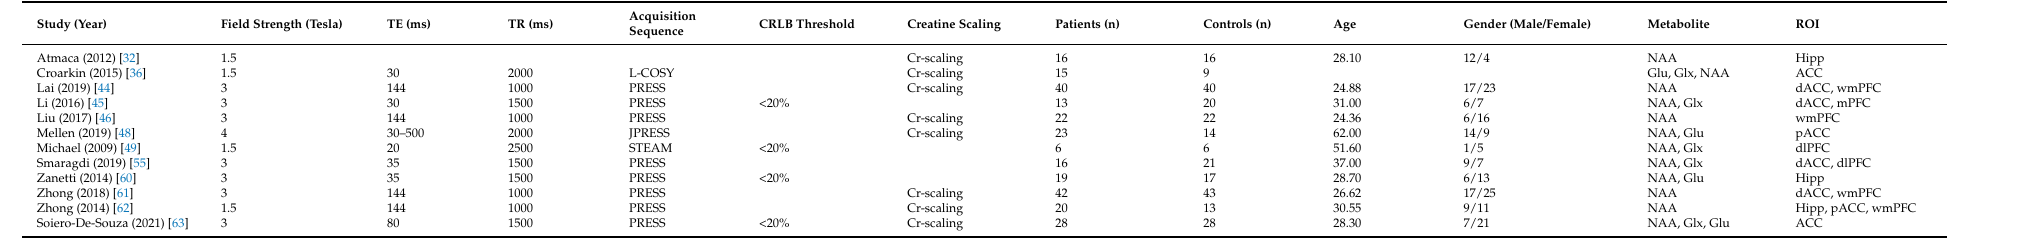
BD = bipolar disorder; TE = time to echo; TR = repetition time; CRLB = Cramer–Rao lower bound; ROI = region of interest; NAA = N-acetylaspartate; Glu = glutamate; Gln = glutamine; mOFC = medial orbitofrontal cortex; dlPFC = dorsolateral prefrontal cortex; mPFC = medial prefrontal cortex; wmPFC = white matter PFC; pACC = perigenual anterior cingulate cortex; dACC = dorsal anterior cingulate cortex; Hipp = hippocampus. Table 2. Characteristics of studies including BD patients in a major depressive